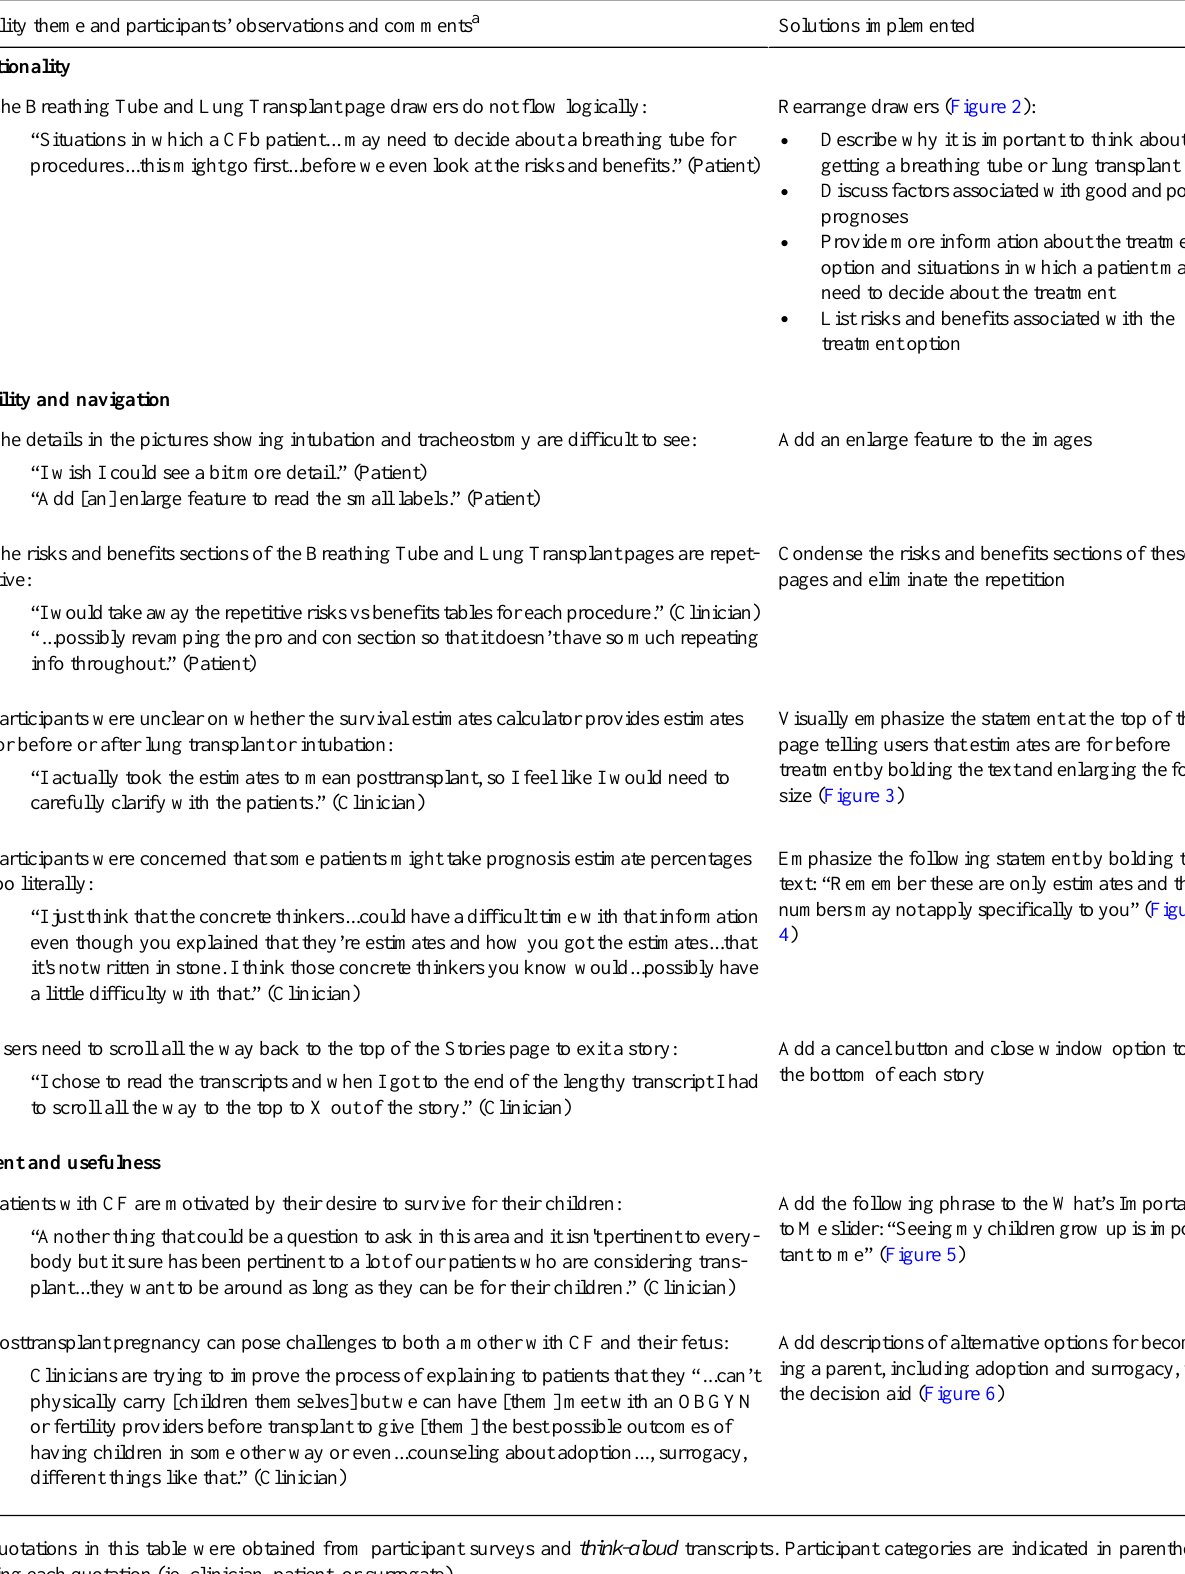
Table 3. Summary of participants’observations and comments and solutions to be implemented, grouped by usability